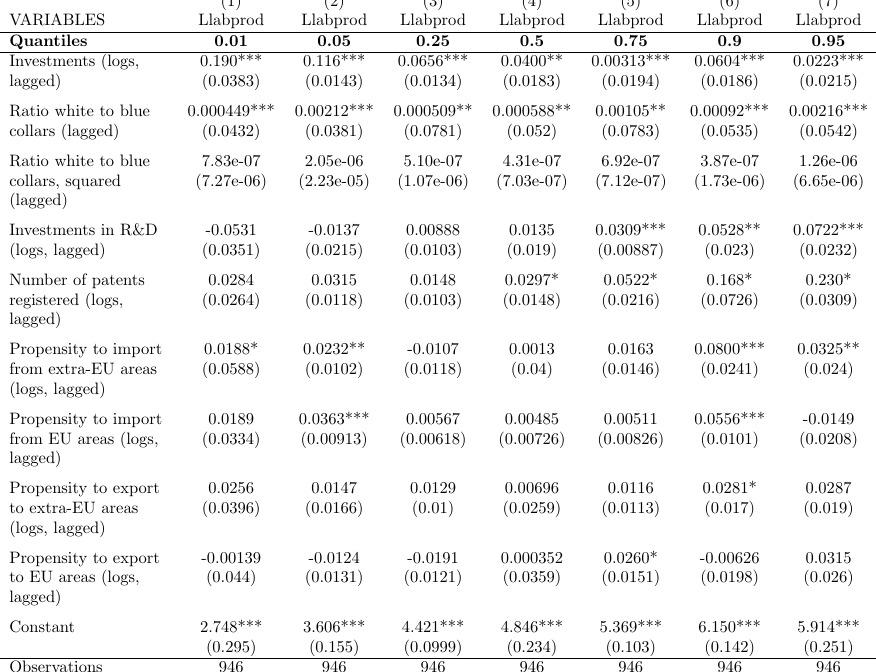
Quantile Regression Results for Trade